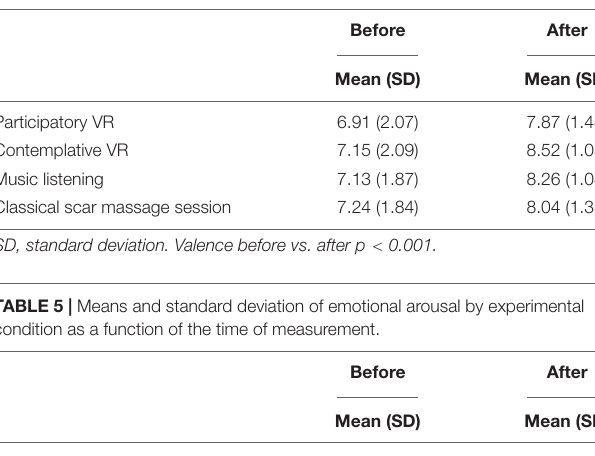
TABLE 4 | Means and standard deviation of emotional valence by experimental condition as a function of the time of measurement.